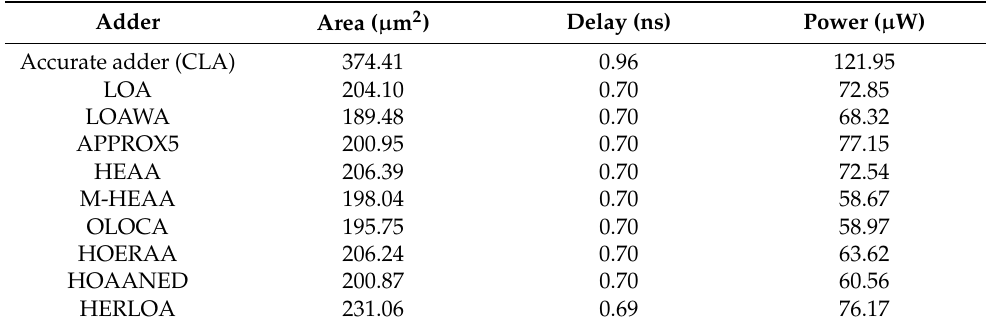
Table 3. Design parameters of accurate and approximate 21-bit adders corresponding to an ASIC-type implementation; the approximate adders have an 11-bit inexact part.